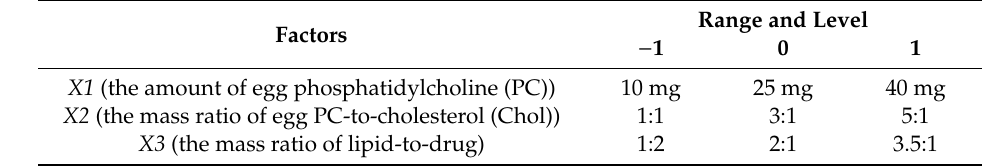
Table 1. Levels of factors used in Box-Behnken design